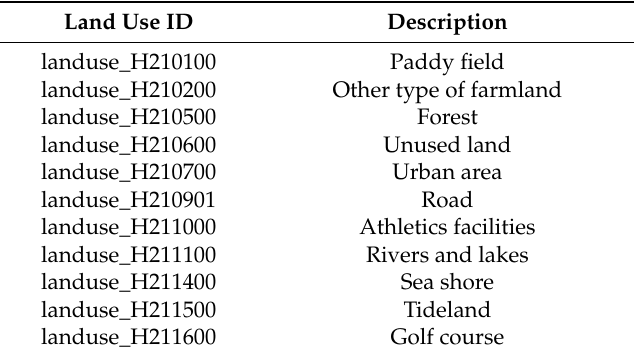
Table 6. Land use ID in the AmGSD system [1].